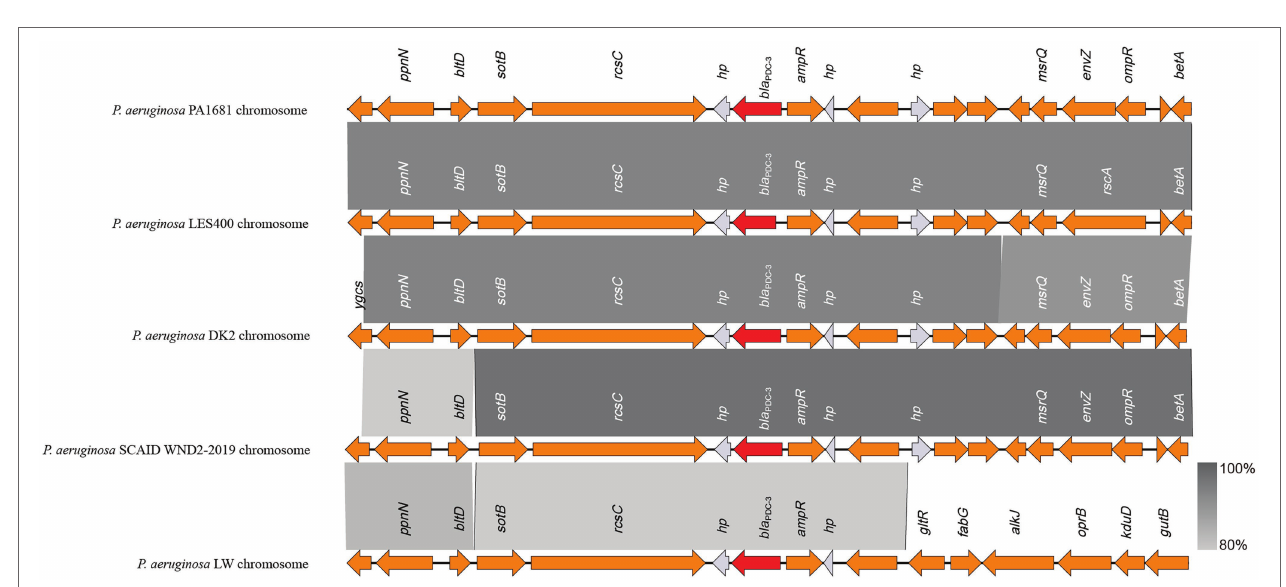
FIGURE 3 | Comparative genomic analysis of the resistance gene regions of pPA1609-475 with other sequences from different bacteria. The homologous gene clusters among the plasmids pPA1609-475, pBM413 (CP016215.1), pPAG5 (CP045003.1), pSY153-MDR (KY883660.1), and pA681-IMP (MF344570.1) with the resistance gene clusters in red. pPA1609-475 contained two class 1 integrons with the bla IMP-45 encoding one carrying 6 resistance genes ( intI1-bla IMP-45 -bla OXA-1 - aac(6 ′ )-Ib7-catB3-qacE ∆ 1 - sul1 ), and the other one contained 5 resistance genes ( intI1-qnrVC1-aar-2-dfrA22-qacE ∆ 1 - sul ). Annotated coding sequences are displayed as arrows. Coding sequences are colored based on their assigned gene functions. The genes in blue are those without direct gene names. The grey shading areas indicate homologous regions (identity >80%). hp., hypothetical protein.